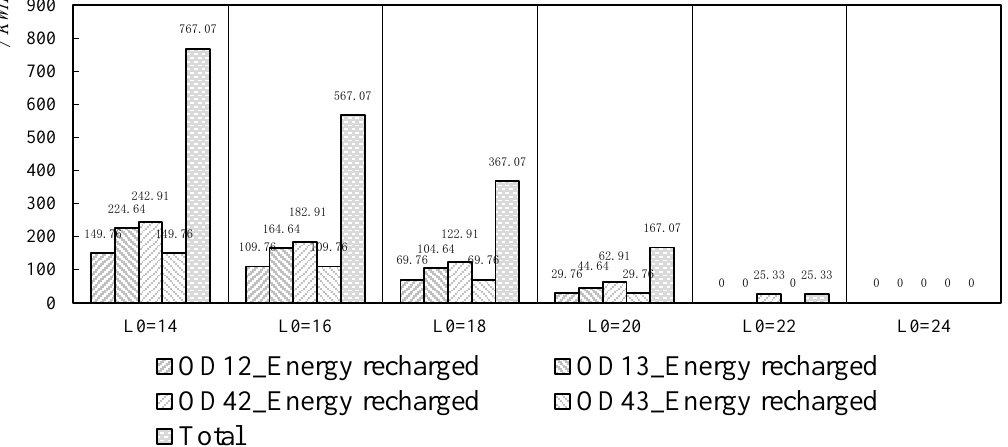
Figure 7. Comparison of the energy recharged for various BEV initial charge levels.